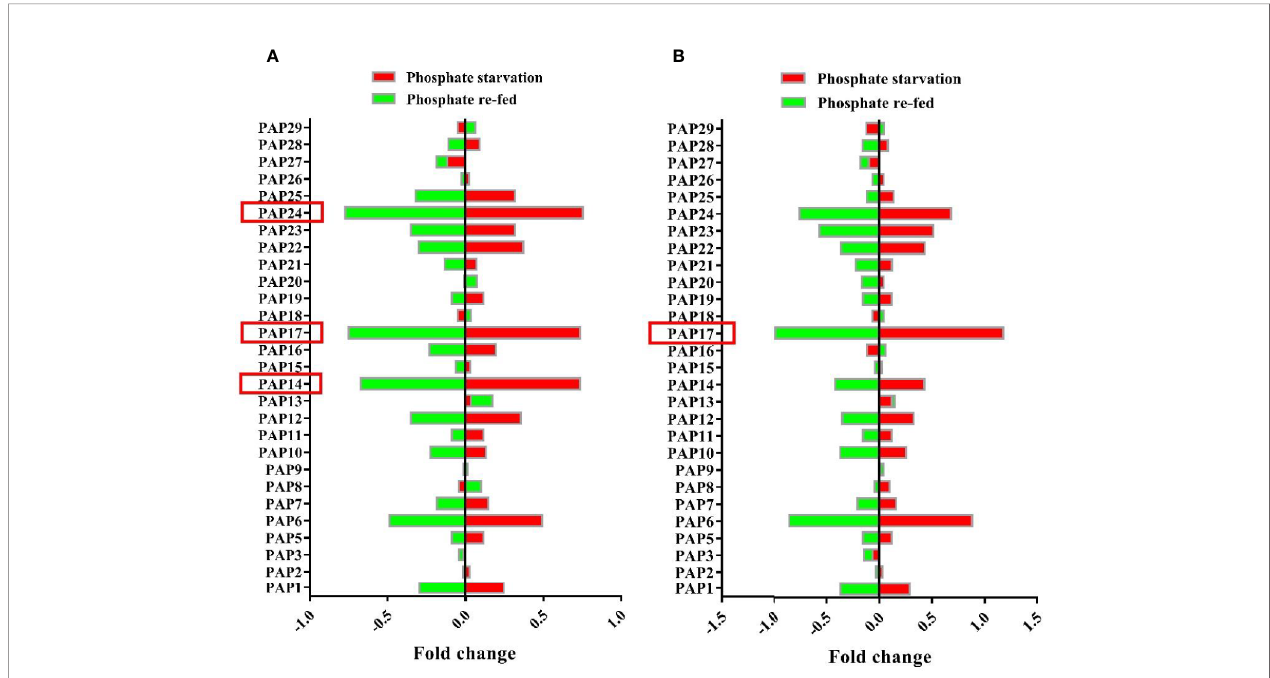
FIGURE 1 | Microarray analysis of gene expression patterns of Arabidopsis PAP family members under Pi starvation and re-fed in seedlings (A) and roots (B) of Arabidopsis plant. Plants were grown hydroponically for 10 days in Pi-suf fi cient (1.75 mM Na 3 PO 4 ) or Pi-de fi cient (no Na 3 PO 4 ) conditions. For Pi re-fed treatment, plants were grown for 10 days under Pi-de fi cient (no Na 3 PO 4 ) conditions and then transferred to +Pi (1.75 mM Na 3 PO 4 ) medium for 3 days. Values are the means of fold changes in PAP-encoding genes expression of three biological